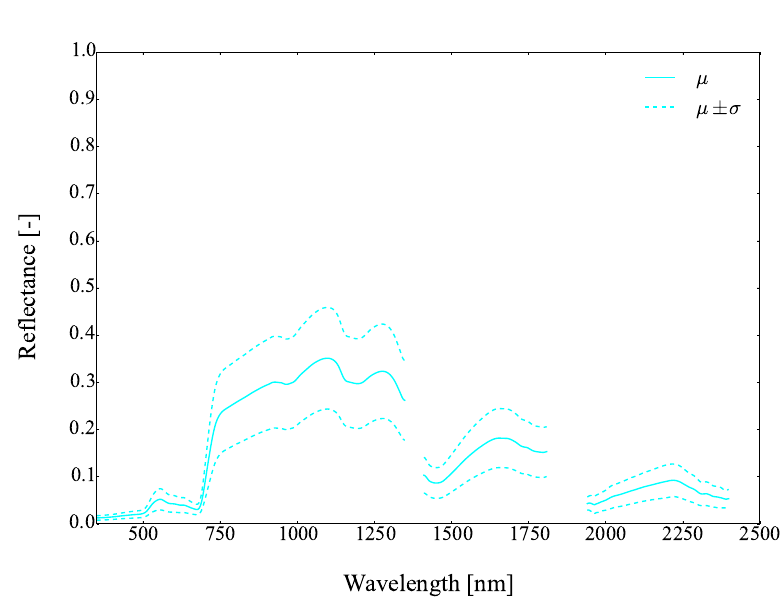
Figure A16. Mean reflectance ( µ ) and standard deviation ( σ ) of Salix sp.